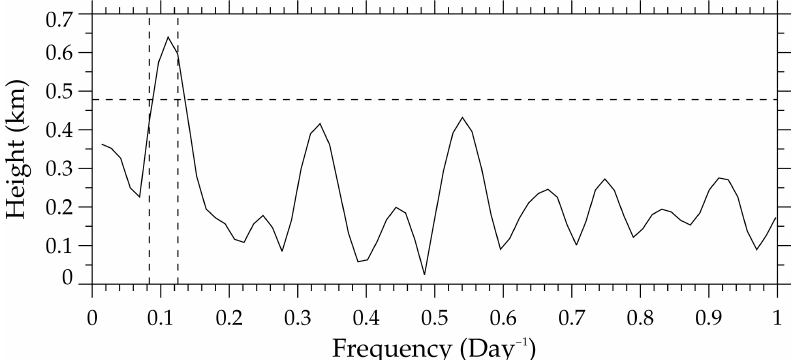
Figure 11. Lomb–Scargle periodogram of the cold point tropopause height from 24 April to 11 May 2020, at Perth Airport deduced from radiosonde observations. The dashed horizontal line denotes the confidence level of 95%. The dashed vertical lines denote the periods of 12 and 8